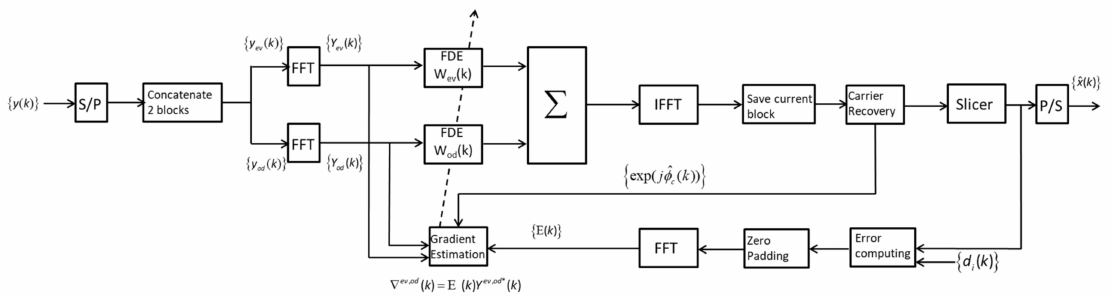
Figure 1. Block diagram of the proposed FDE for one mode